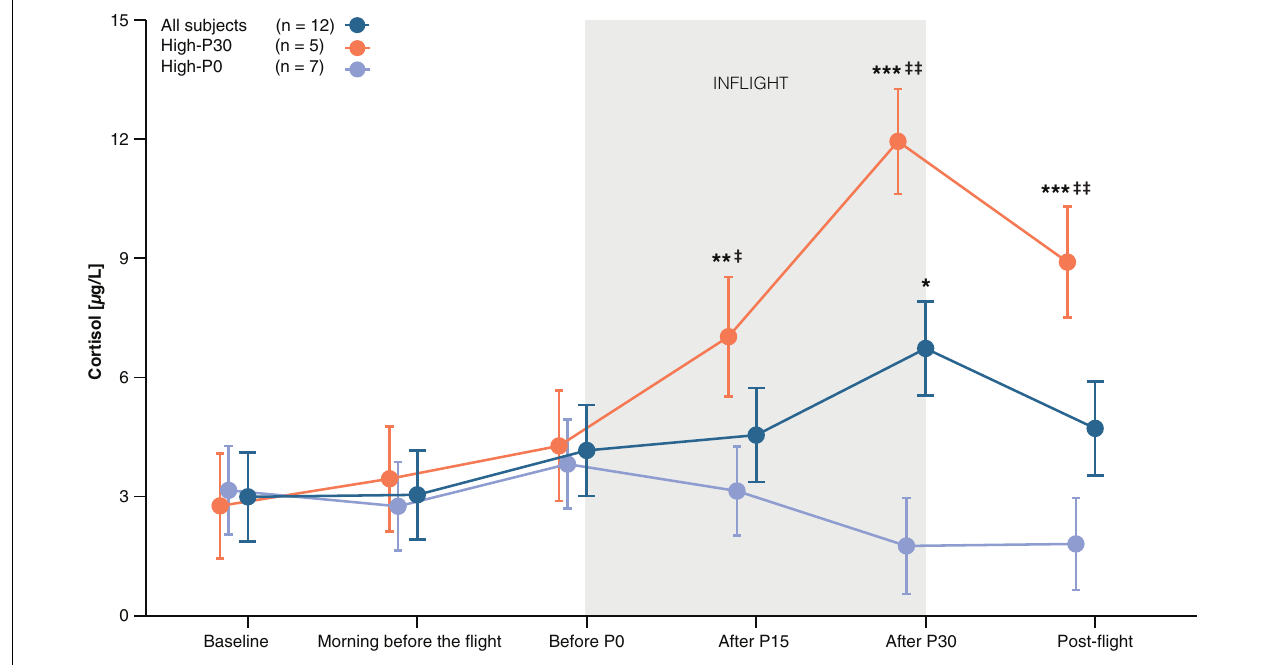
FIGURE 4 | Time course of salivary cortisol levels. Baseline saliva was collected between 9 am and noon on the day of arrival. Two different patterns could be observed, with the highest measured cortisol either after P30 (High-P30) or before P0 (High-P0). Orange line represents participants of High-P30, violet line represents participants of High-P0, dark blue line shows data of all participants. Data are presented as marginal means ± SE. * P < 0.05, ** P < 0.01, *** P < 0.001 compared to baseline, ‡ P < 0.05, ‡‡ P < 0.001 compared to High-P0.